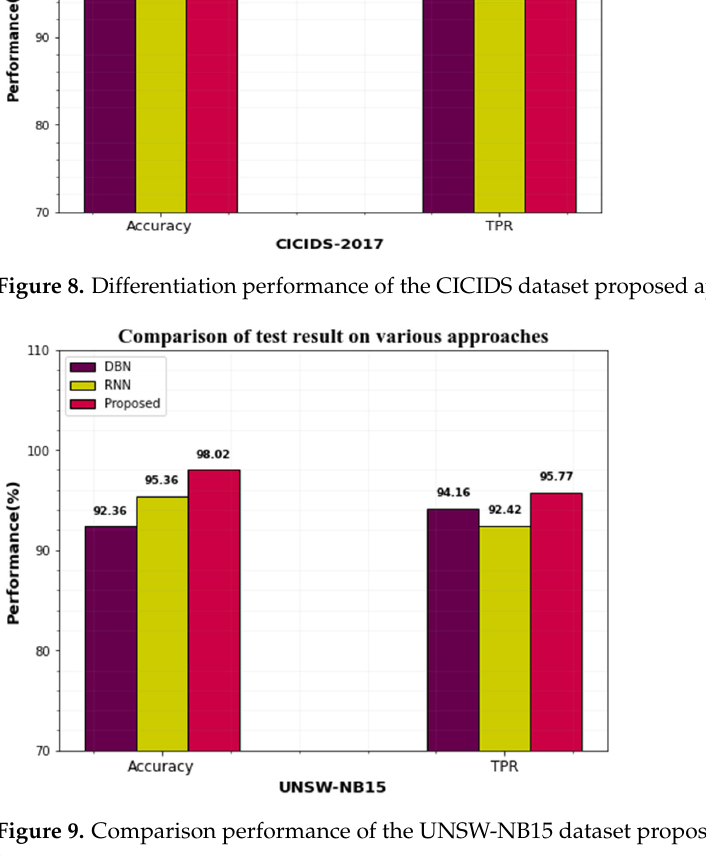
Figure 9. Comparison performance of the UNSW-NB15 dataset proposed approach with the exist- ing one.